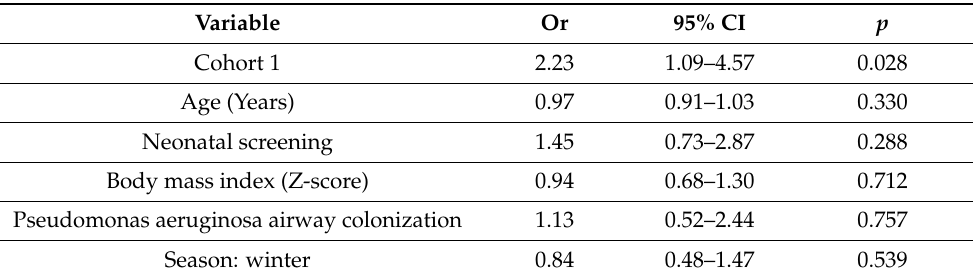
Table 4. Results of multivariable linear regression for risk of vitamin D insuffiency (serum 25 OH vitamin D < 30